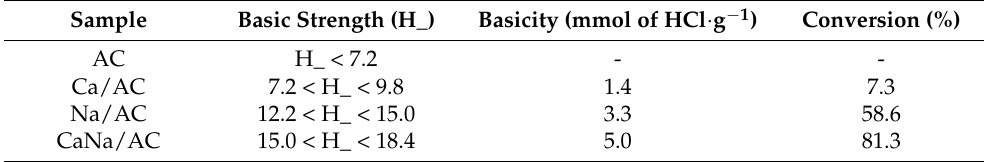
Table 1. Basic strength, basicity, and catalytic activity of AC, Ca/AC, Na/AC, and CaNa/AC.